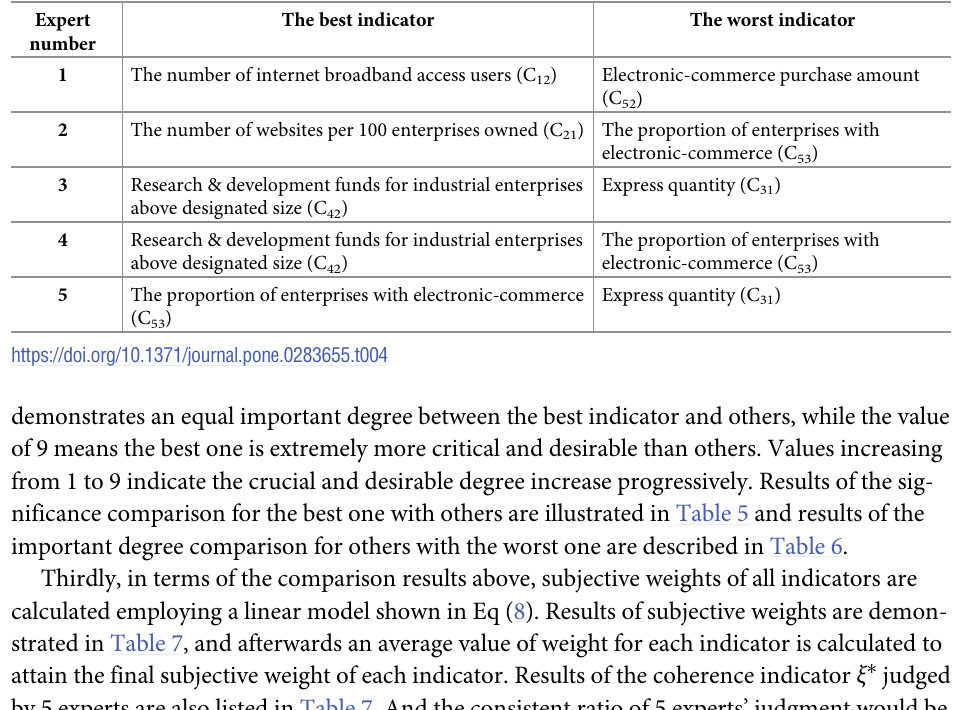
Table 4. The best and the worst indicator chosen by 5 experts.